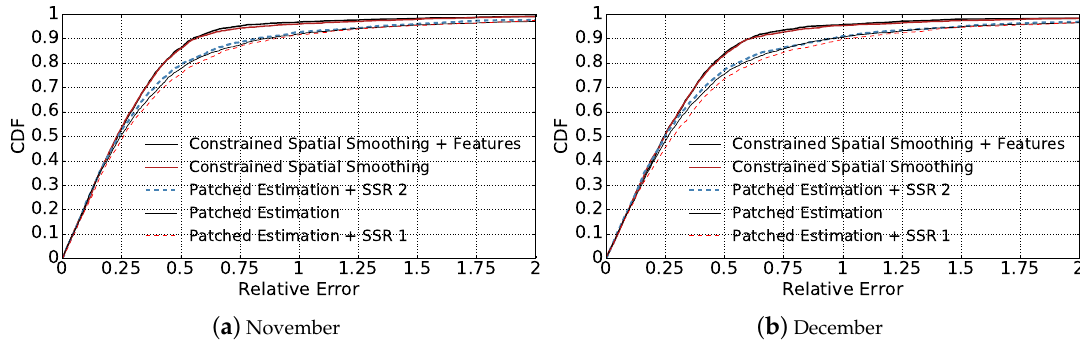
Figure 3. Comparison of the CDFs of estimation relative errors given by different methods when n BS = 200. The legends follow the same order as the curves at relative error = 0.5. ( a ) compares the CDFs based on the data aggregated in November; ( b ) compares the CDFs based on the data aggregated in